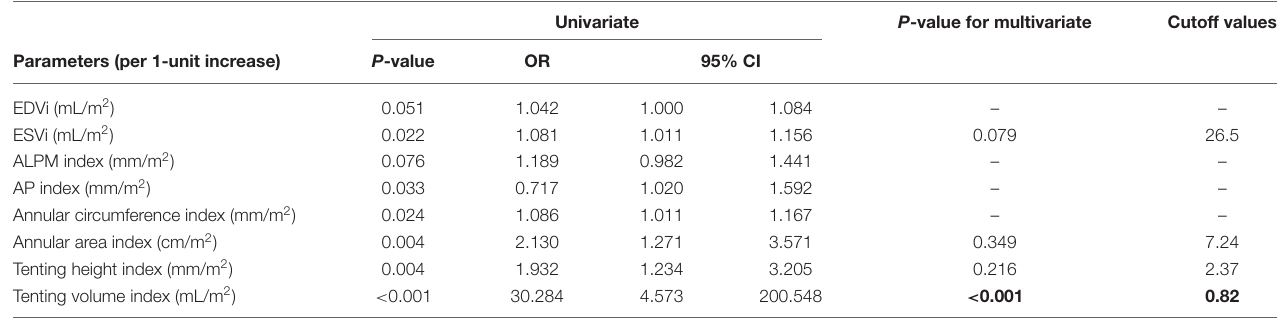
TABLE 3 | Univariate and multivariate logistic regression analysis of anatomic determinants of residual MR 2 + . Univariate P -value for multivariate Cutoff